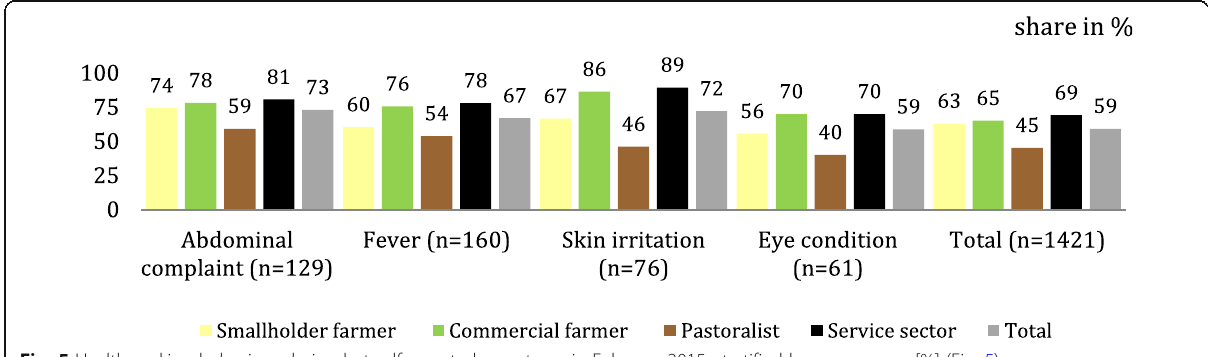
Fig. 5 Health-seeking behaviour during last self-reported symptoms in February 2015, stratified by user groups [%] (Fig. 5)